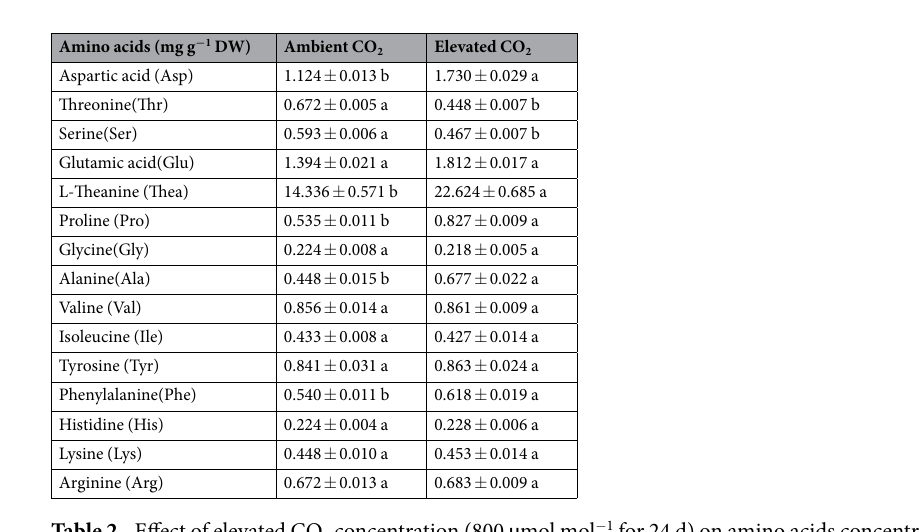
In Arabidopsis, elevated CO 2 causes a metabolic perturbation that compels plants to increase its functions or activity by consuming or storing photoassimilates 16 . In the current study, elevated CO 2 might also increase pro- duction and consumption of photoassimilates in tea plants by enhancing net photosynthesis and respiration rate, respectively (Figs 1–3). It is to be noted that an enhancement in photosynthesis under elevated CO 2 could provide